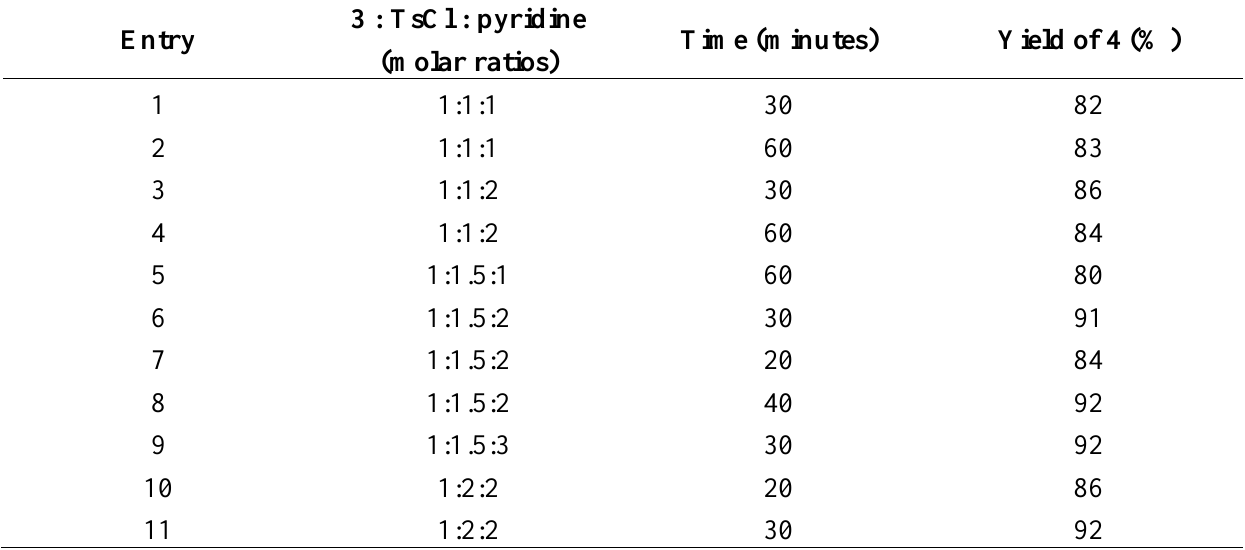
Table 1 : Preparation of the tosylate 4 under ultrasound irradiation.